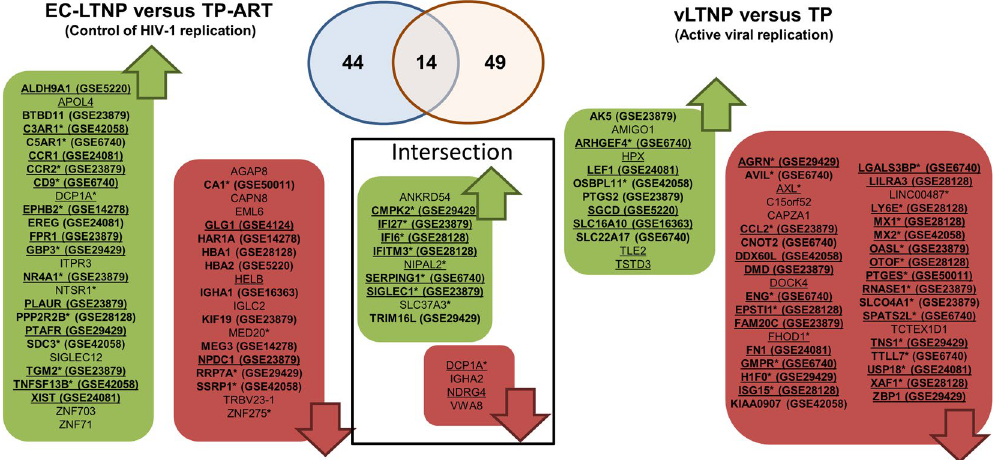
and red boxes show upregulated and downregulated DEGs, respectively. Genes regulated by interferon are underlined whereas genes associated with an active viral replication (identified by the comparison of TP